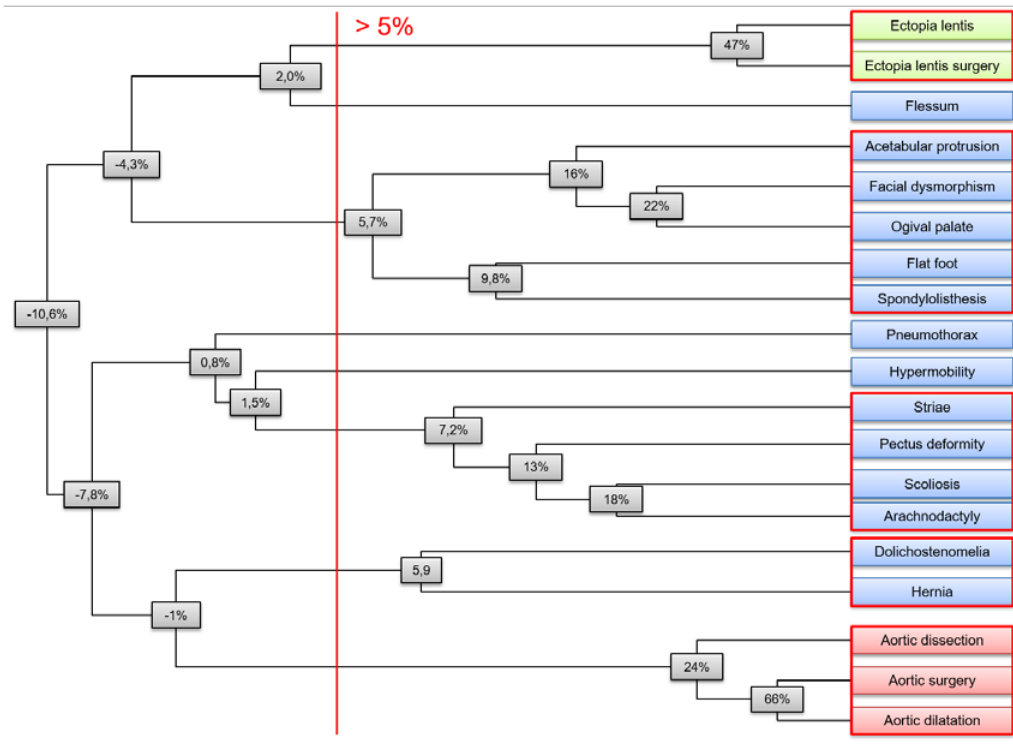
Figure 2. Agglomerative hierarchical clustering of clinical features of MFS. Agglomerative hierarchical clustering showed ocular (in green), cardiovascular (in red), and systemic clusters (in blue). Complete linkage clustering was chosen as linkage criteria, and the metric was Pearson correlations coe ffi cient corrected for covariates. Node values indicate the minimal correlation between any couple of features within the corresponding subtree. On the right, the five clusters given by a 5% threshold are circled in